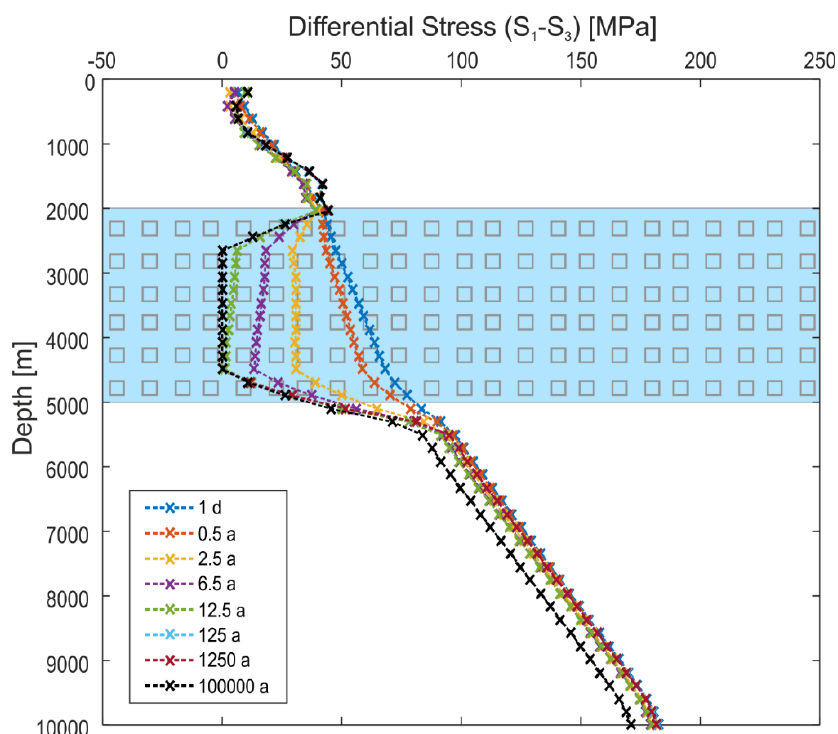
Figure 12 : Differential Stress (S 1 –S 3 ) after different total times for Model B-04b along the hypothetical well W1 (Figure 2). The blue line corresponds to the total time after the initial increment of 1 × 10 5 s and the black line to the total time after the last increment (3.154 × 10 12 s). All times are roughly rounded.